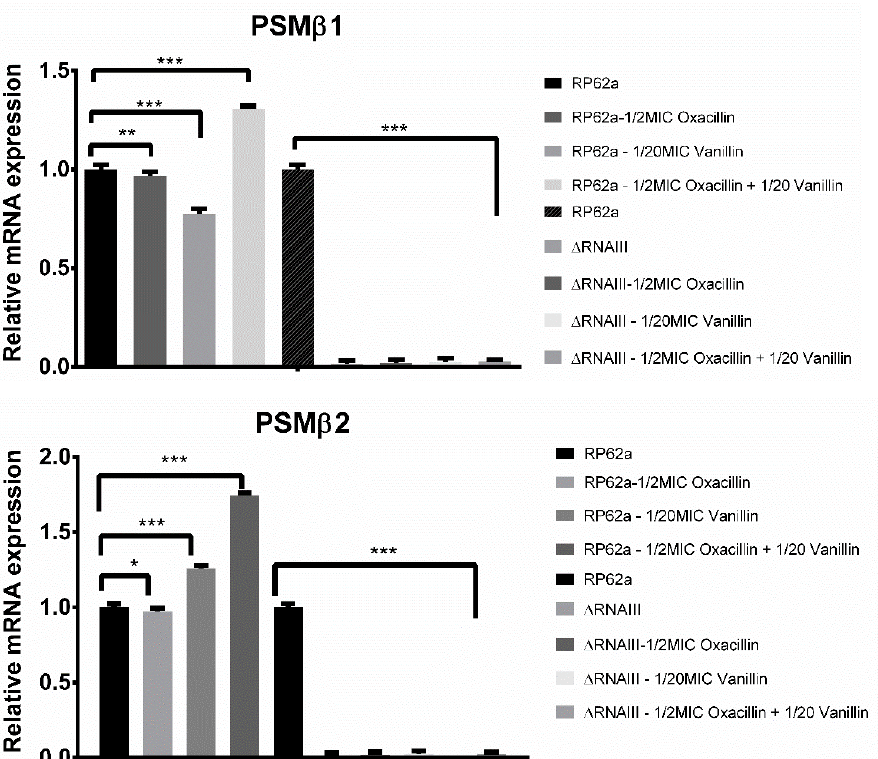
Figure 8. Real-time qPCR analysis of RNAIII-independent genes psm β 1 and psm β 2. For both genes, relative mRNA expression was decreased compared to the control. As a control, a housekeeping gene for 16S rRNA and an unaffected culture were used (* p < 0.01, ** p < 0.001, *** p < 0.0001).